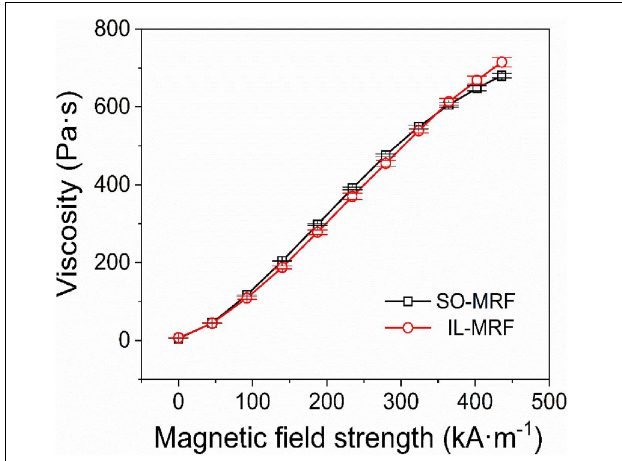
FIGURE 5 | Dependence of the storage modulus G (cid:48) and loss modulus G (cid:48)(cid:48) of SO-MRF and IL-MRF on magnetic field at 0.01% stain amplitude and 10 rad · s − 1 angular frequency.